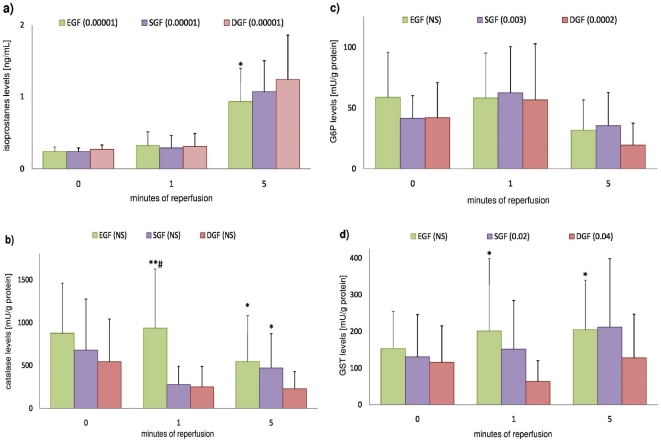
Mean isoprostanes, catalase, G6P and GST values stated in consecutive minutes of graft reperfusion, and statistical comparison of these means between examined groups.(A) Isoprostanes, (B) Catalase, (C) G6P and (D) GST. EGF – early graft function, SGF – slow graft function, DGF – delayed graft function group, GST – glutathione transferase, G6P – glucose-6-phosphate dehydrogenase. P values in parentheses represent result of Friedmann's ANOVA test for appropriate group. *p<0.05; **p<0.01 – level of significance for differences between means (vs DGF). #p<0.05 – level of significance for differences between means (vs SGF).